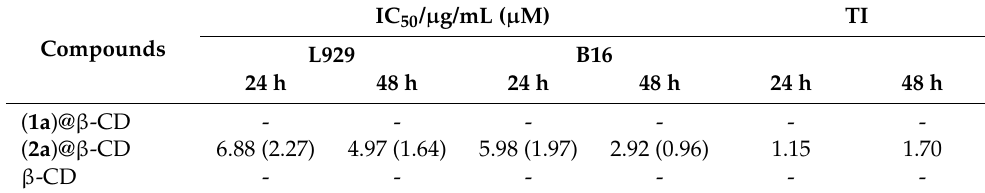
Table 2. IC 50 values and calculated TI for the compounds tested.